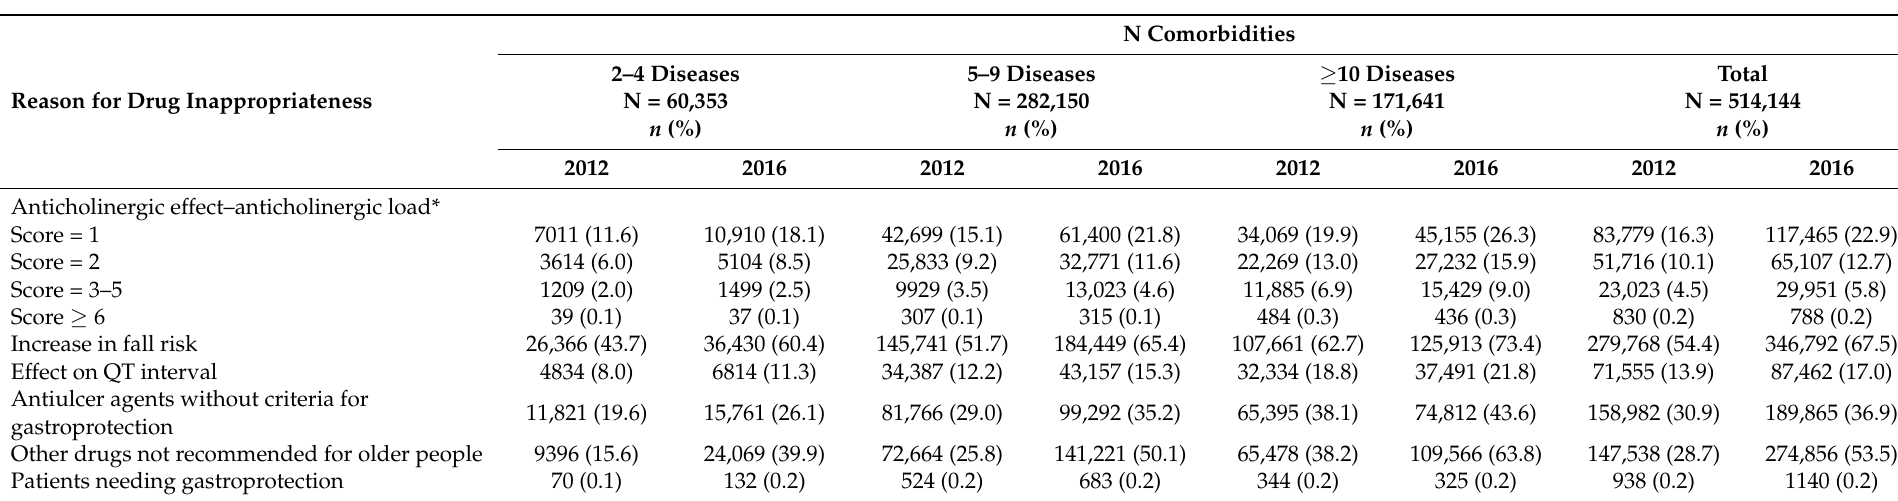
Table 3. Potentially inappropriate medications in older people by multimorbidity group at baseline and at the end of the study (N =